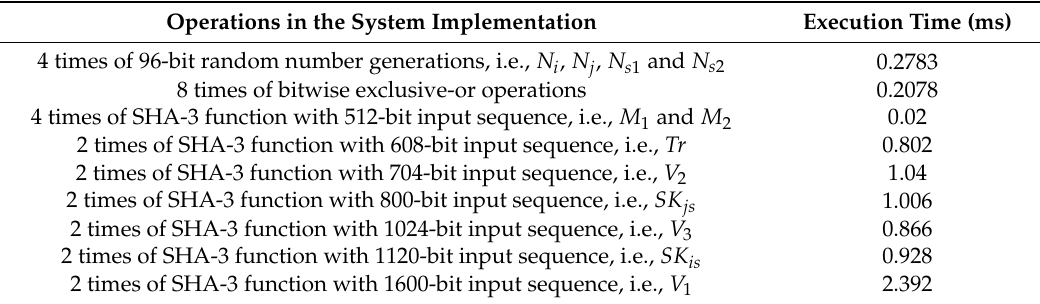
Table 6. The details of the implementation of the authentication phase without Tr seq